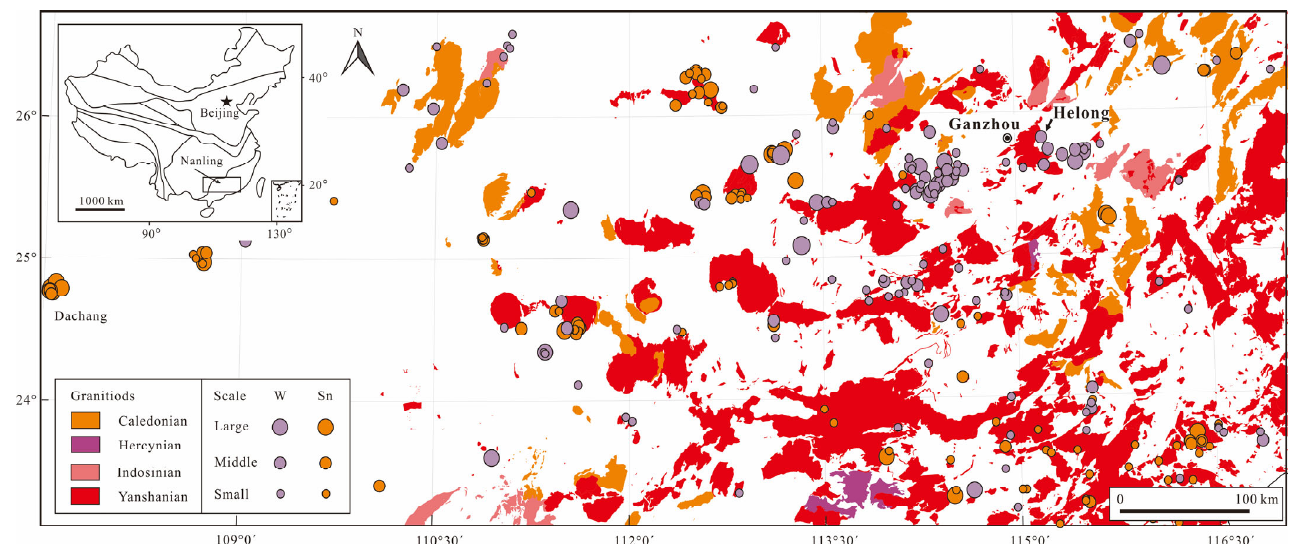
Figure 1. Distribution map of granitoids and major Mesozoic W–Sn deposits in Nanling region (modified from [ 4 ]).